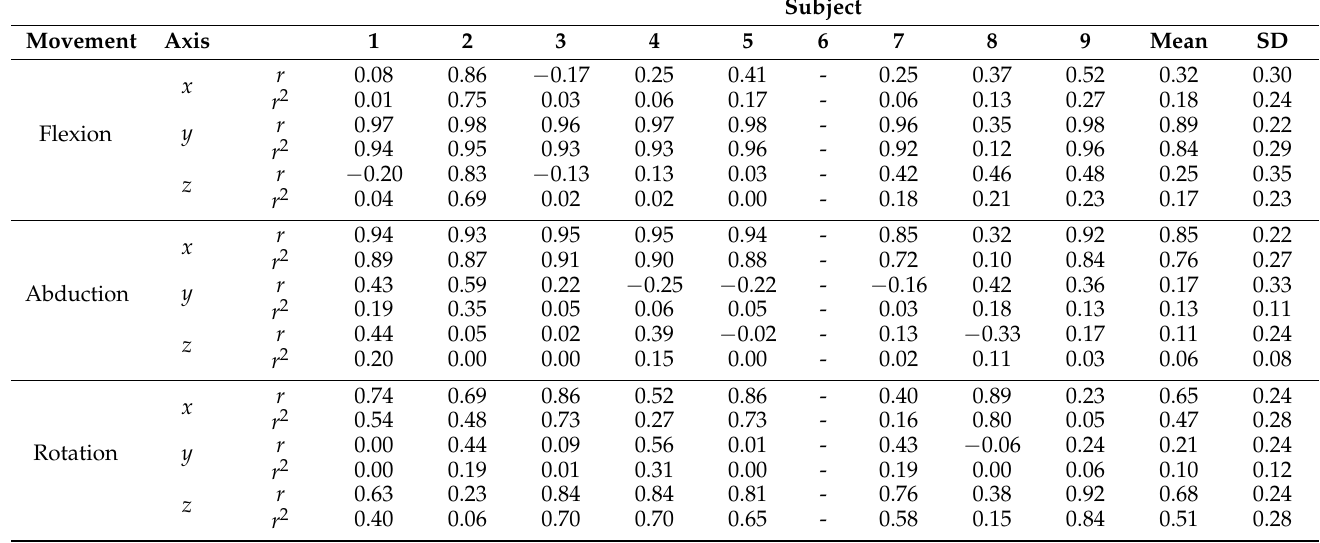
Table A1. ANN-based method performance in handling known loads. Shown are the correlations between the net moment at L5/S1 estimated with the ANN-based method and with the LSM-based method. Correlations are represented by the Pearson correlation coefficient (r) and the determination coefficient (r 2 ) and are shown by the axes anterior–posterior (x), mediolateral axis (y) and the longitudinal axis (z). Shown are individual values for each subject plus the mean and standard deviation (SDD) over all subjects. No valid data were obtained for subject number 6 for reasons of partially missing data in the 6 kg